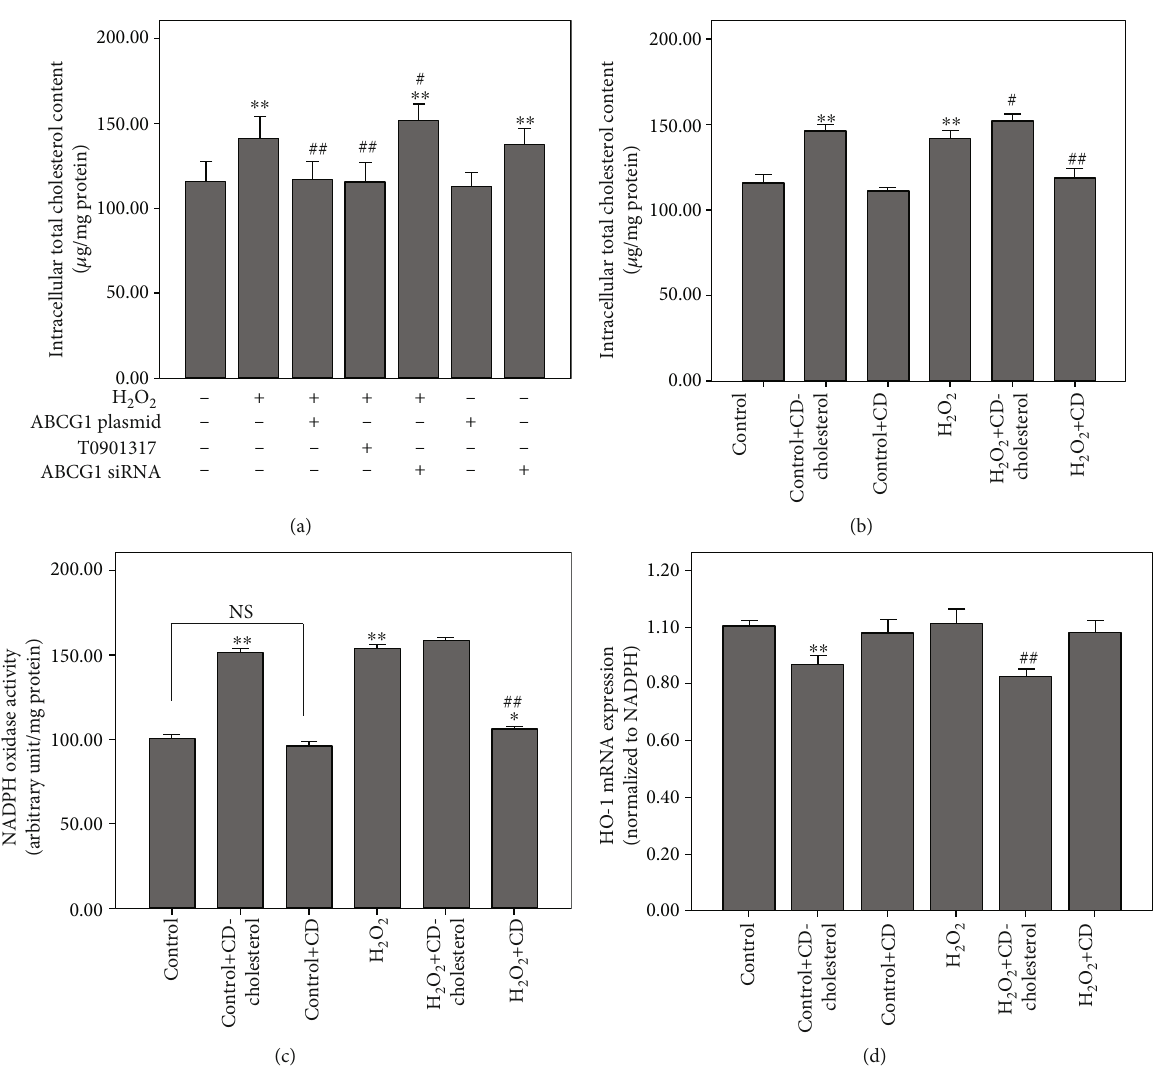
Figure 5: E ff ect of intracellular cholesterol accumulation on prooxidant NADPH oxidase activity and antioxidant HO-1 expression. (a) HUAECs were transfected with the speci fi c ABCG1 siRNA or ABCG1 overexpression plasmid or preincubated with T0901317 and then treated with H O or not. Intracellular total cholesterol contents were measured by a microenzymatic fl uorescence assay. (b) Intracellular 2 2 total cholesterol contents were measured after cholesterol repletion or cholesterol depletion using cholesterol-loaded cyclodextrin (CD) or M β CD in HUAECs. (c) NADPH oxidase activity was detected after cholesterol repletion or cholesterol depletion in HUAECs. (d) HO-1 mRNA expression was measured by real-time PCR after cholesterol repletion and cholesterol depletion in HUAECs. Data shown are means ± SD ( n = 3 ). ∗ P < 0 : 05 and ∗∗ P < 0 : 001 vs. controls; # P < 0 : 05 and ## P < 0 : 001 vs. HUAECs incubated with H